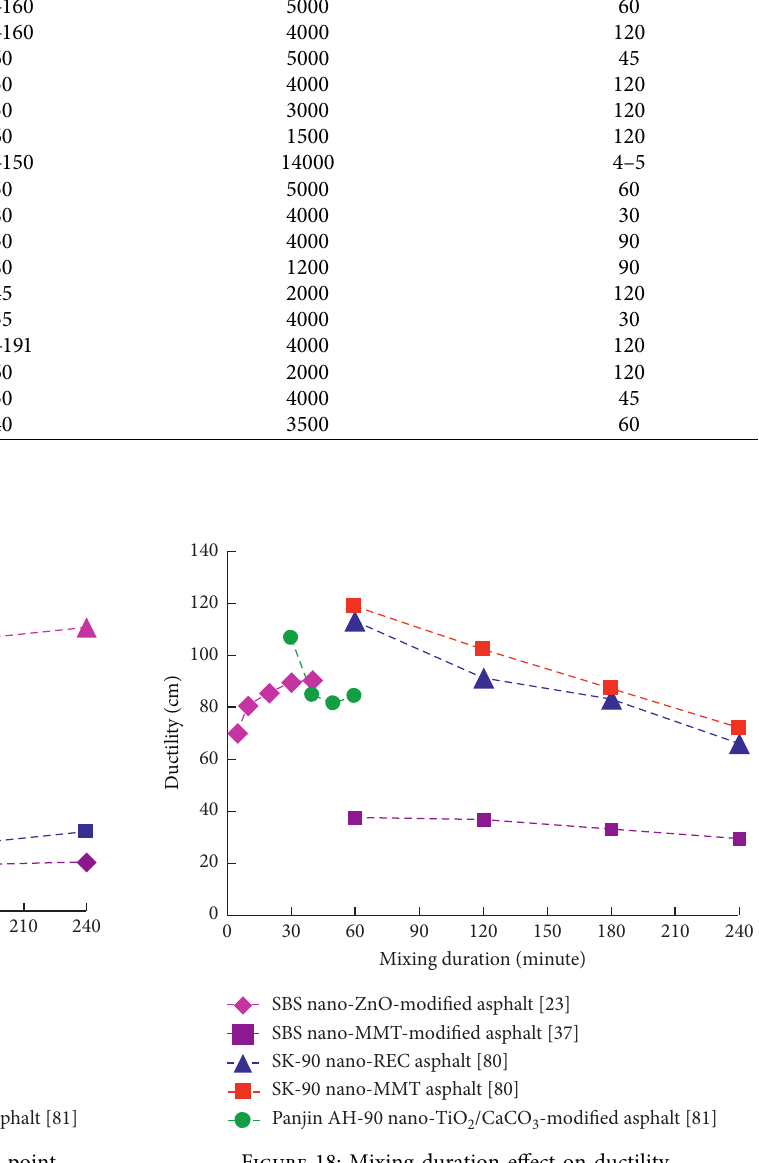
Figure 17: Mixing duration effect on softening point.